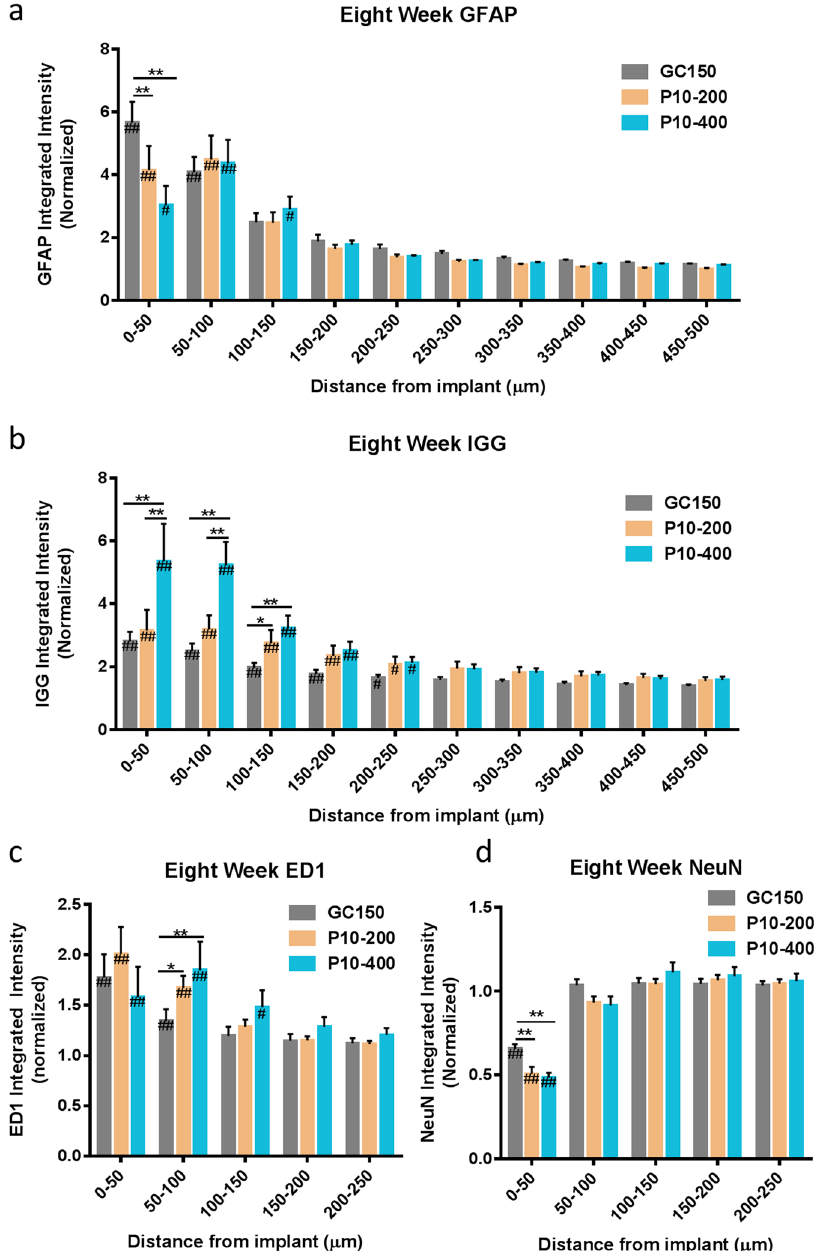
Figure 6. The response to thick hydrogel coatings on smaller diameter implants exhibits both mechanical and size effects at eight weeks post implantation. ( a ) Mechanically matched hydrogel coatings reduce GFAP at 8 weeks post implantation compared to smaller diameter hard implants. Effects from the increased implant size of the hydrogel coatings were also observed. The hydrogel coated implants had ( b ) increased IgG staining directly surrounding the implant, ( c ) increased macrophage activity, and ( d ) decreased neural density compared to the 150 micron diameter glass capillaries. These results highlight the tradeoff in mechanical benefits and size effects from increasing the overall implant diameter following the addition of a hydrogel coating. ** p < 0.01, * p < 0.05 indicates a statistically significant difference between cohorts at a given distance from the implant interface. ## p < 0.01, # p < 0.05 indicates a statistically significant difference compared to background. No significant differences were observed beyond the distances shown in the figures. Cohort sizes GC150: n = 18, P10–200: n = 7, P10–400: n = 6. Each n corresponds to an individual animal. A minimum of four sections were analyzed per